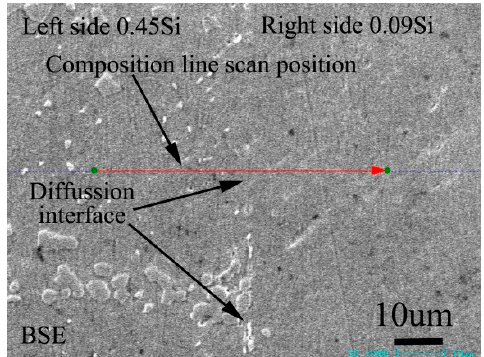
Figure 3. Microstructure of diffusion couple sample after 1000 °C/200 h heat treatment: left side is 0.45Si alloy and right side is 0.09Si alloy.